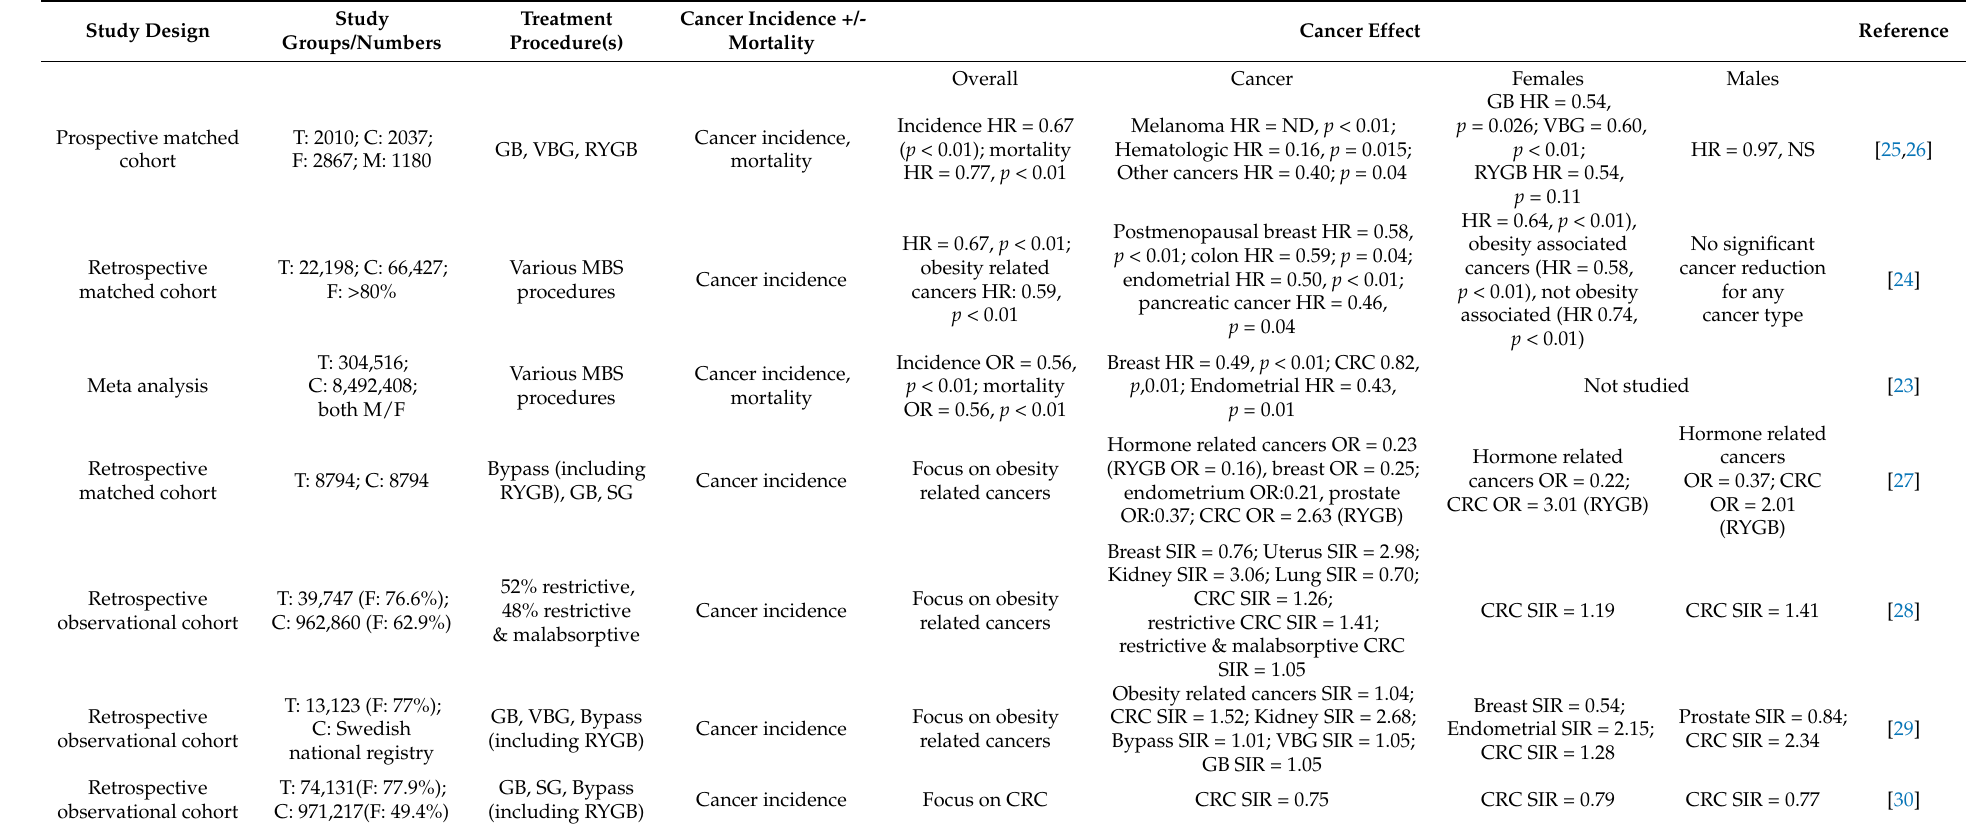
Table 2. Effects of MBS on cancer incidence and